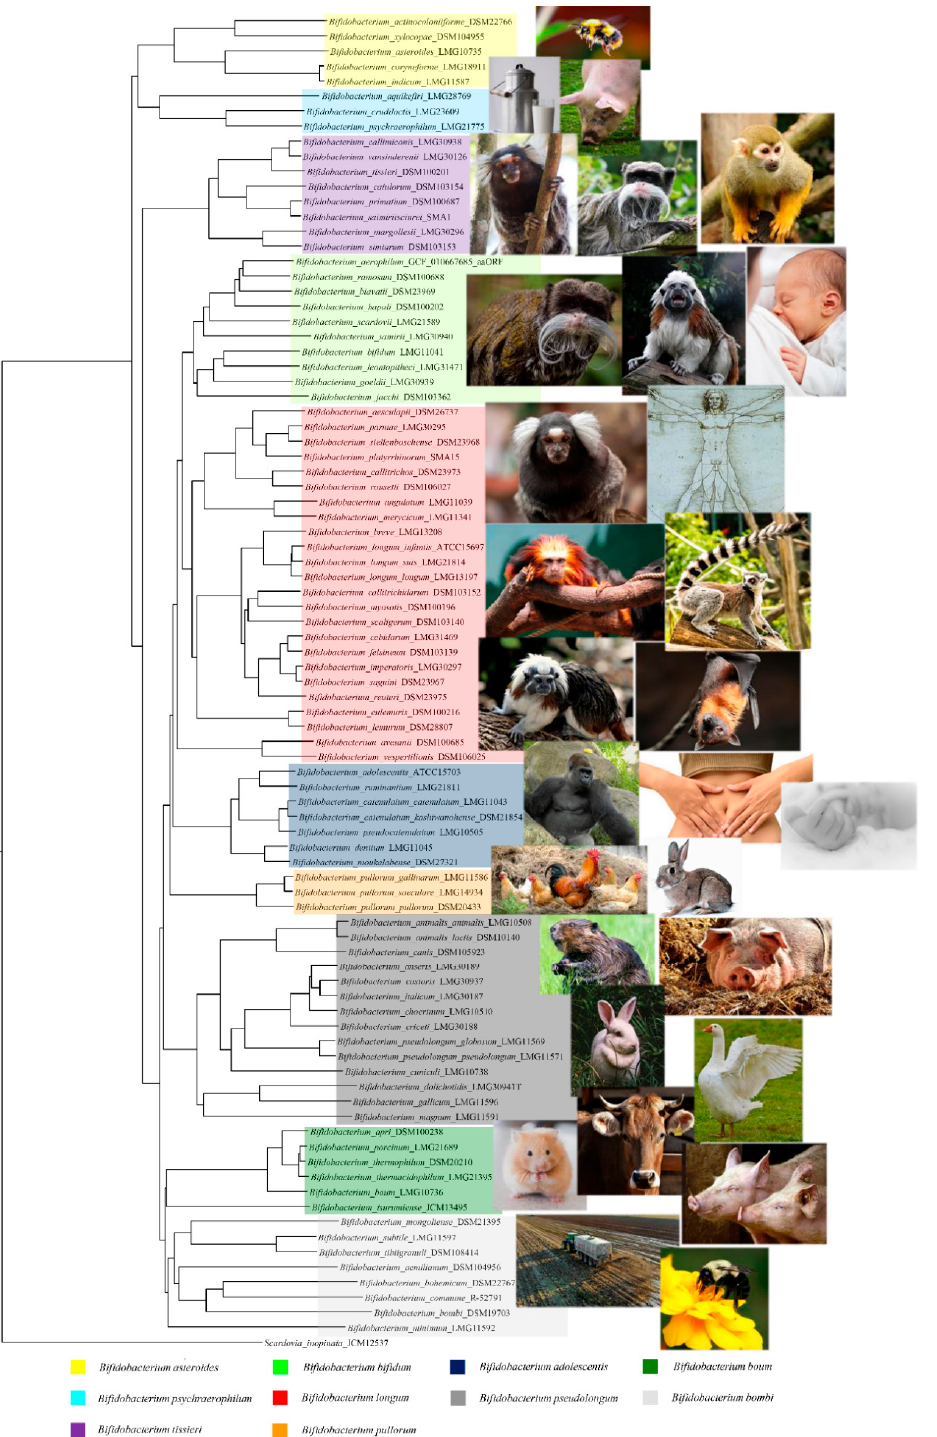
Figure 1. Phylogenetic tree of the Bifidobacterium genus based on the concatenation of 191 core amino acid sequence genes. The core genes-based tree shows the subdivision of the 10 phylogenetic groups of the Bifidobacterium genus represented with different colors. The phylogenetic tree was built by the neighbor-joining method with corresponding sequences of Scardovia inopinata JCM 12,537 being employed as outgroup. Bootstrap percentages above 50 are shown at node points, based on 100 replicates of the phylogenetic tree. The ecological origins of the various phylogenetic groups are highlighted beside the phylogenetic